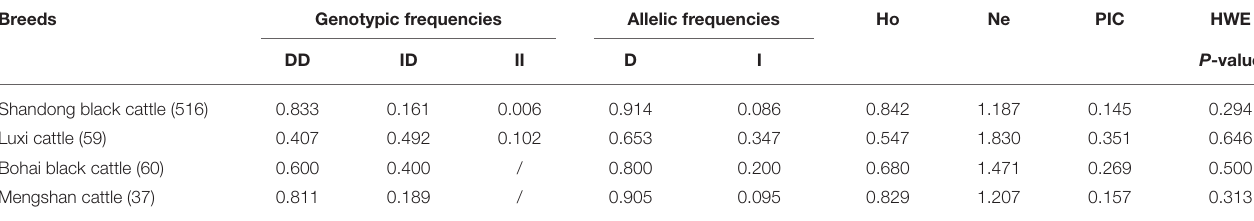
TABLE 3 | Genetic diversity of the 12 bp indel within the bovine LOC100847835 promoter region in the four cattle breeds.